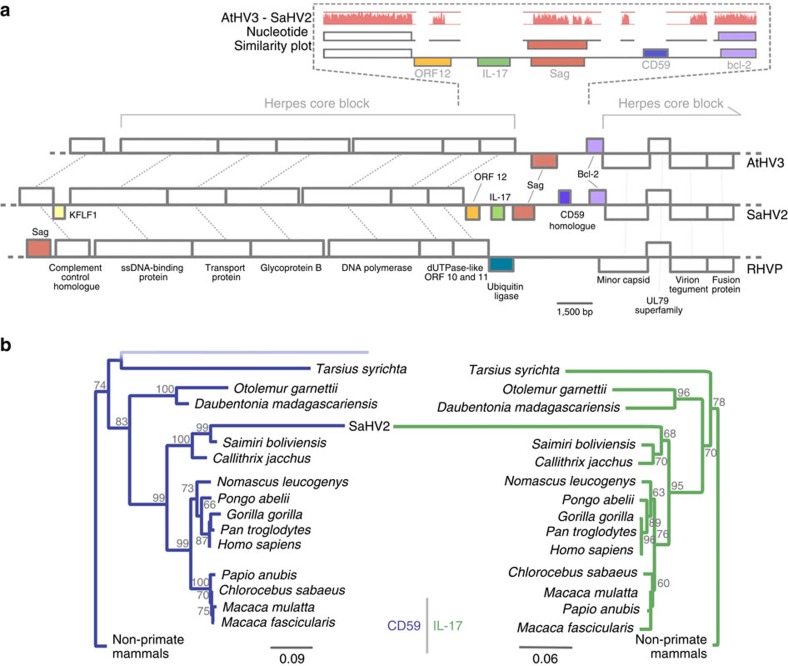
The herpesviral sag locus.(a) Cartoon of a partial genome alignment of SaHV2, AtHV3 and RHVP, showing conserved gene blocks in blank boxes and lineage-specific genes in colour, labeled according to product name. The figure also shows an alignment for SaHV2 and AtHV3 of the region between ORF11 and the minor capsid gene. The red graph depicts the percentage nucleotide-level similarity shared by the viruses. (b) Maximum-likelihood phylogenies of host IL-17 and CD59 from primates including a viral homologue in SaHV2. SaHV2 independently acquired these genes after diverging from AtHV3. The gene for CD59 in particular, appears to have been captured from the squirrel monkeys, which are the current host of the virus. Only the primate tips have been made visible. The scale bar represents the number of nucleotide substitutions per site. The results of 1,000 nonparametric bootstrap replicates are indicated at each node.